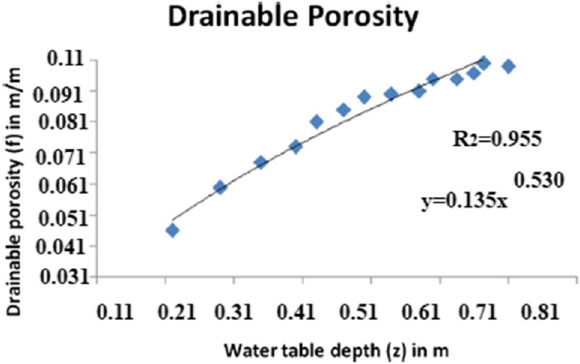
Fig. 1 Difference of drainable absorbency with water table